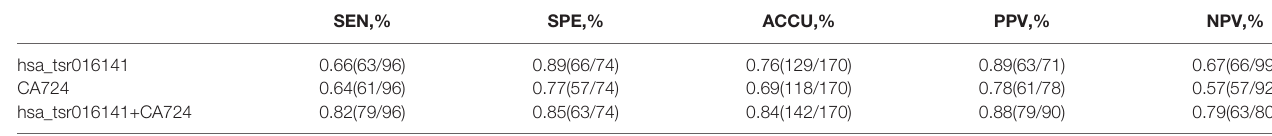
TABLE 4 | Use the expression levels of hsa_tsr016141 and CA724 to distinguish GC patients from healthy donors. SEN,% SPE,%